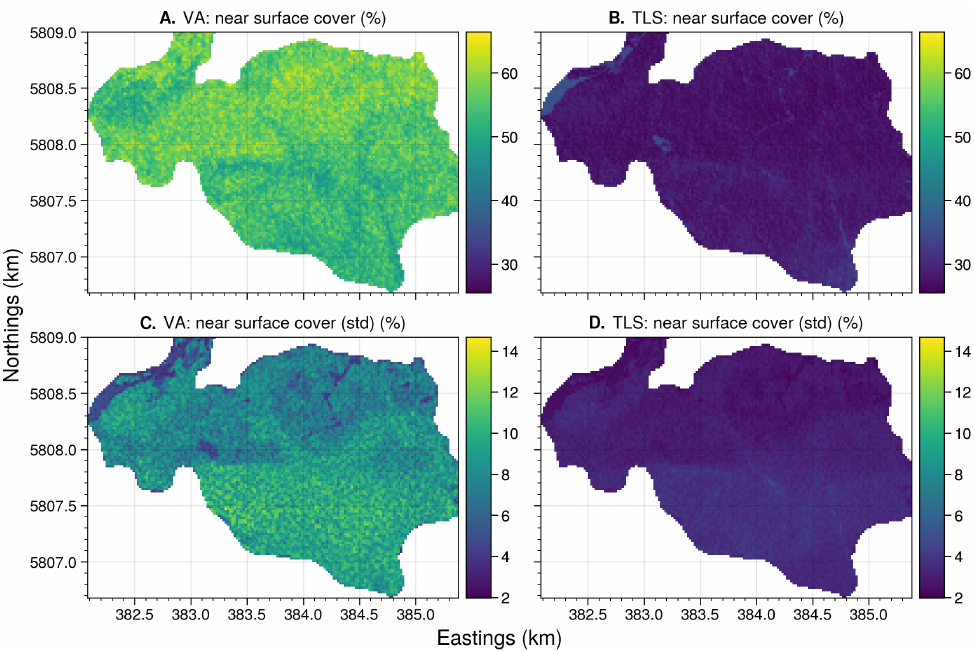
Figure A13. The mean and standard deviation of landscape-level predictions for near-surface fuel cover using visual assessments ( A , C ) and TLS ( B , D ) at Three Bridges.